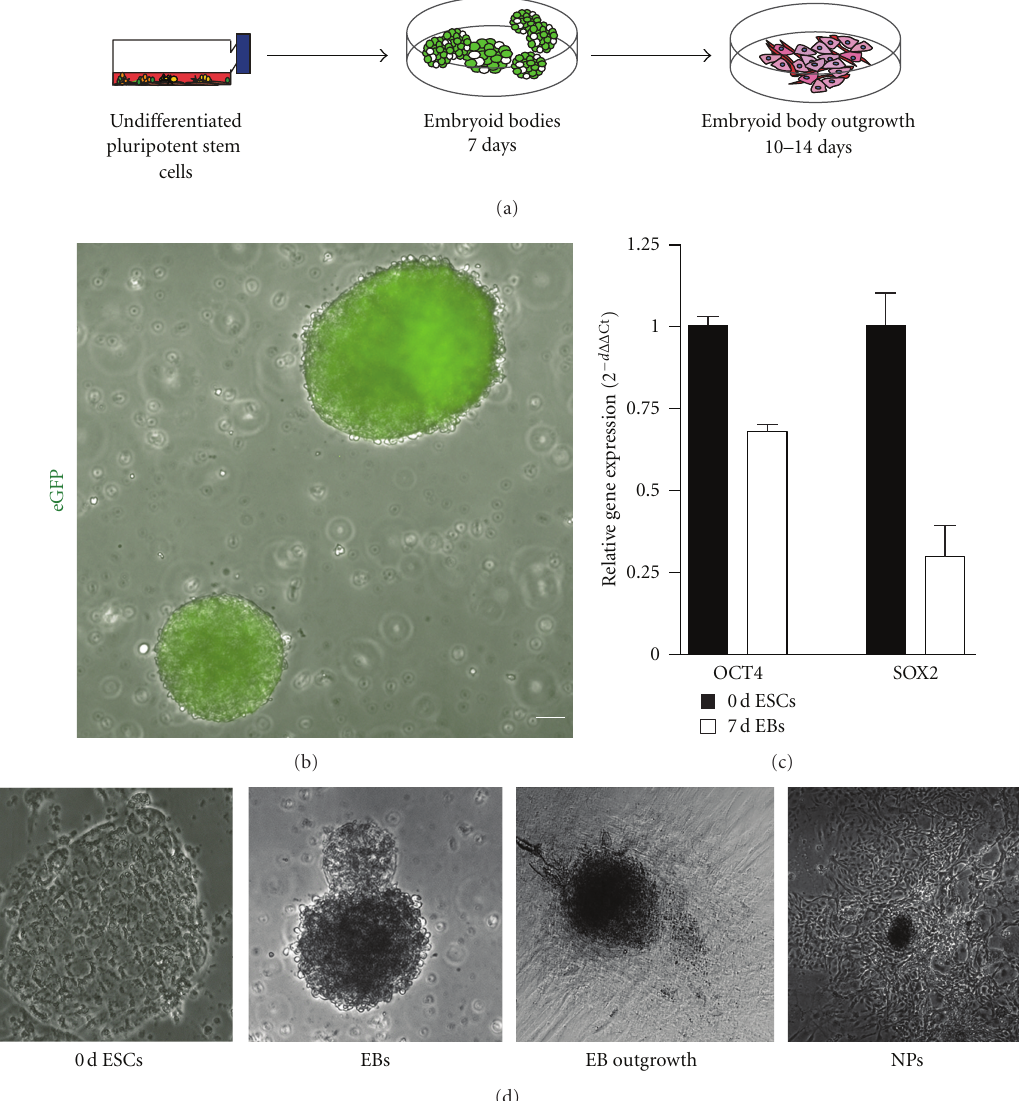
Figure 3: Di ff erentiation of cell progenitors associated with the central nervous system (CNS) and the neural retina. (a) Experimental overview for in vitro di ff erentiation of CESCs. (b) Constitutive eGFP expression in di ff erentiated aggregates of cjes001 EBs. (c) Q-PCR analysis of OCT4 and SOX2 pluripotency markers in undi ff erentiated cjes001 (0-day ESCs) and 7-day EBs. (d) Changes in morphology during in vitro di ff erentiation. Arrowheads indicate EB outgrowth observed 1 week after replating. Neurites resembling neural progenitors (NPs) were formed 10–14 days after replating. Scale bars, 50 μ